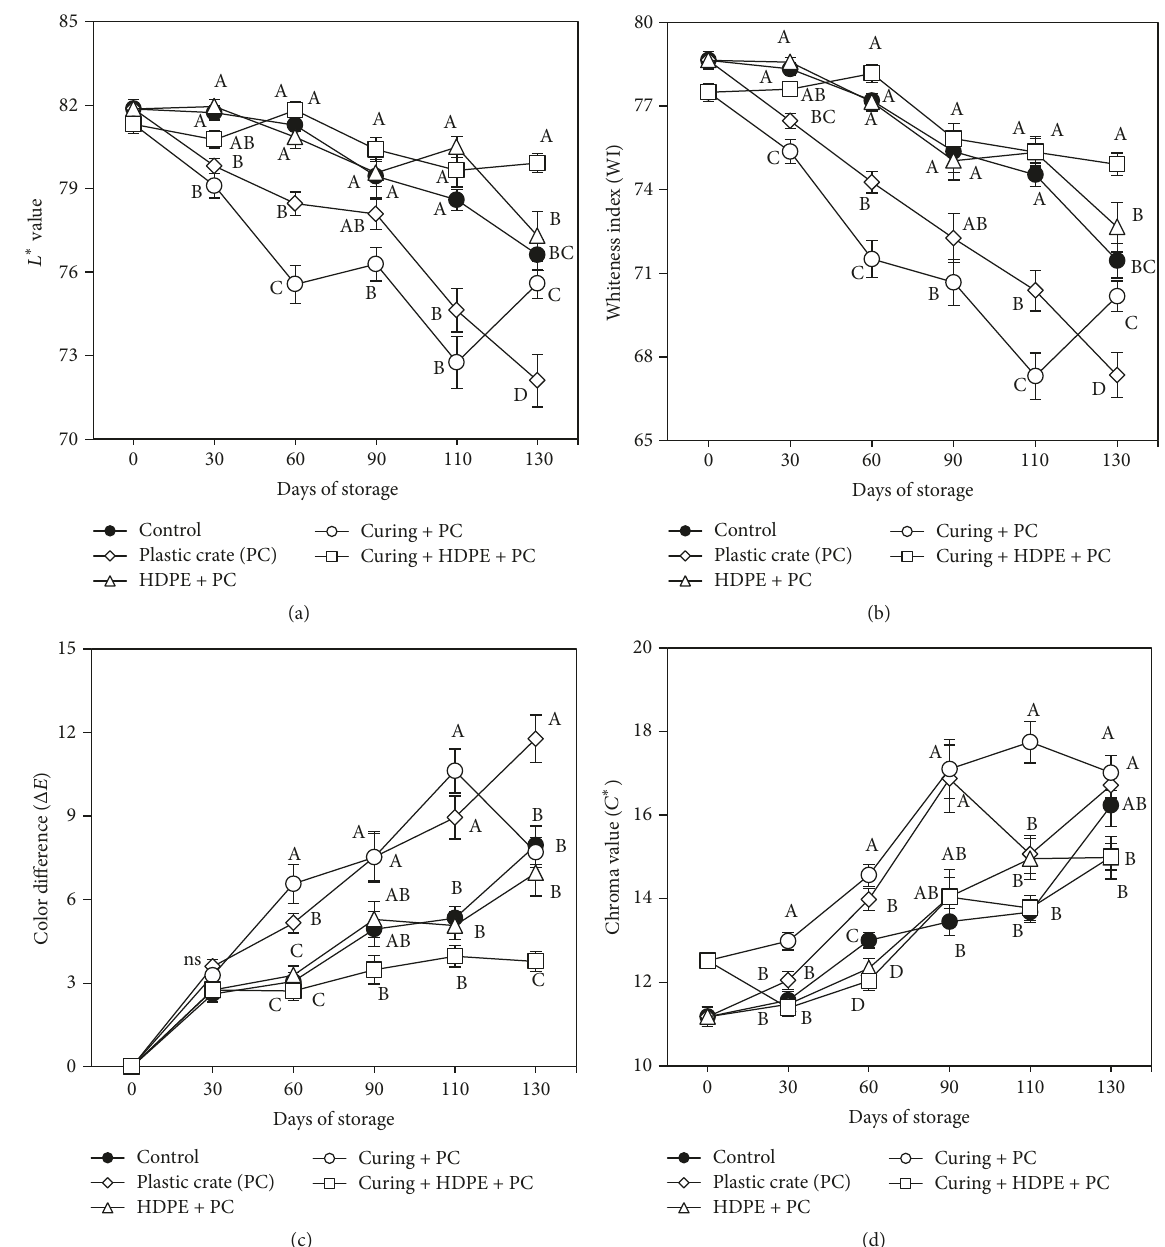
Figure 4: Changes in color parameters, that is, 𝐿 ∗ value (a), whiteness index (b), color difference (c), chroma value (d) of radish roots during storage at low temperature under different packaging treatments. Vertical bars represent ± SE of mean. For each evaluation day, different letters indicate significant differences ( 𝑃 < 0.05 ) among